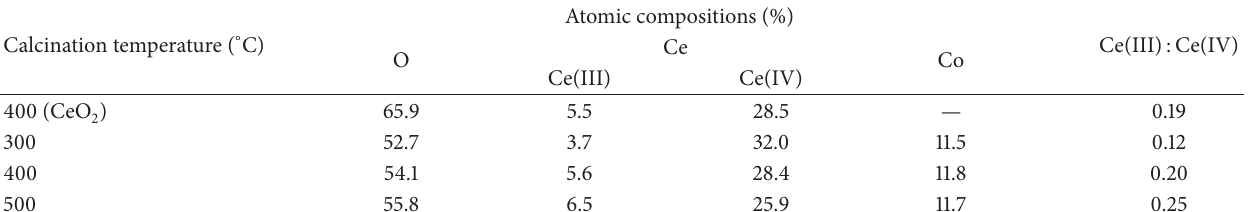
and 5 wt.% Co O /CeO samples at different 2 3 4 2